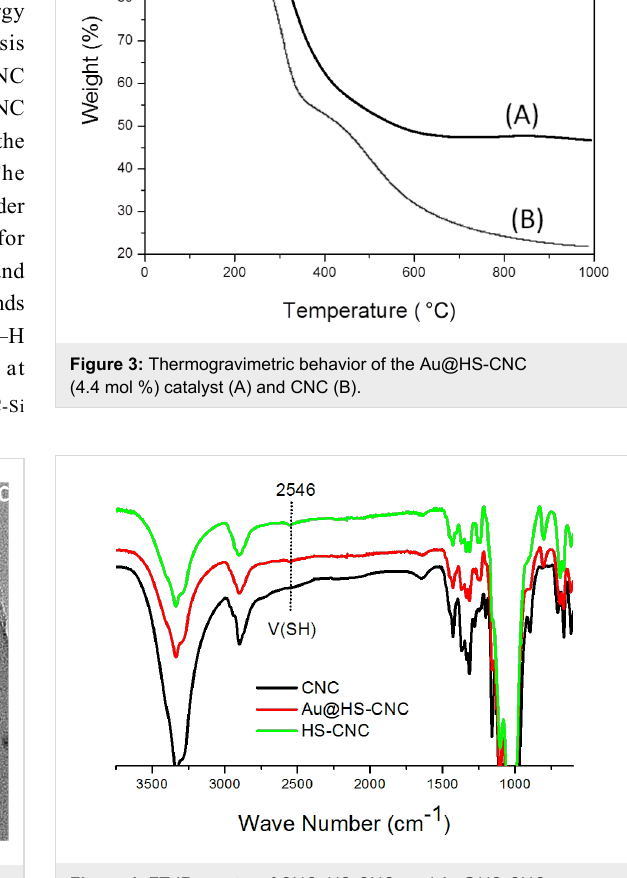
Figure 2: TEM pictures of the HS-NCC and Au@HS-CNC (4.4 mol %) catalyst (scale bar: 5 nm).